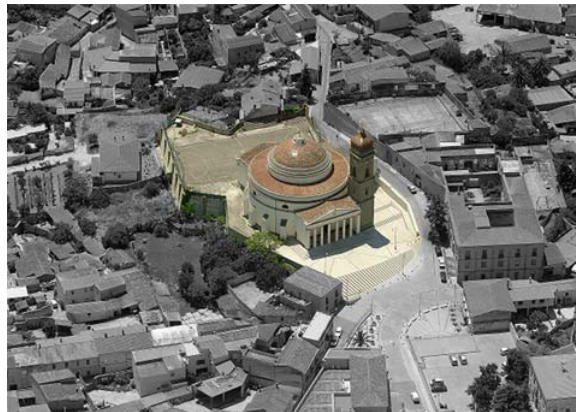
Figure 5:Aerial view of the